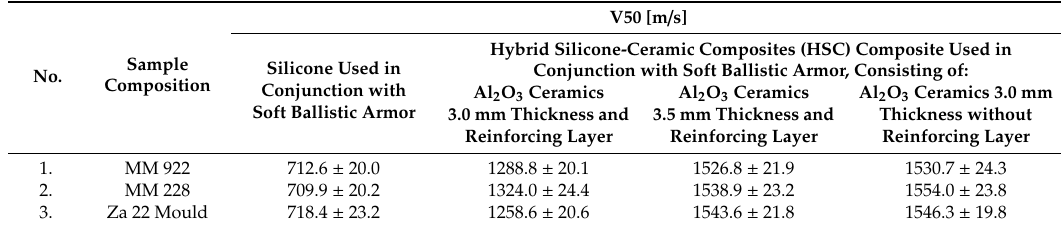
Table 5. Fragmentation resistance test